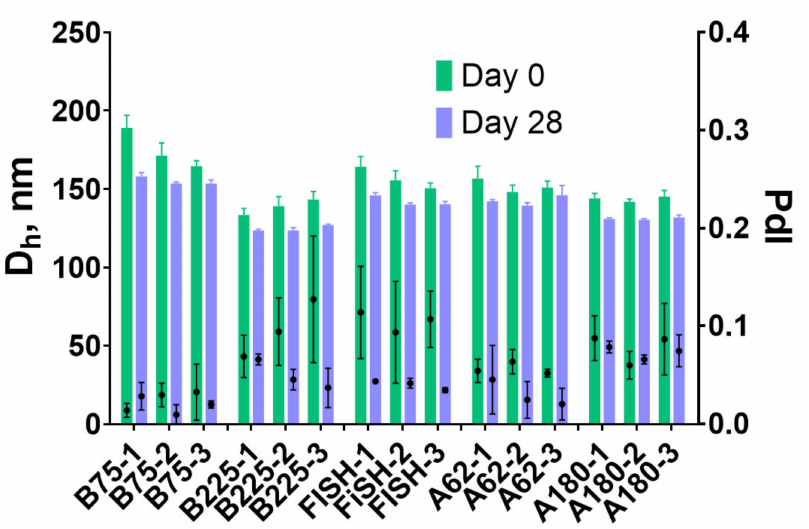
Figure 7. Size (Dh) and polydispersity index (PdI) of gelatin nanoparticles after the synthesis and in 28 days. Mean values of three technical replicates are shown, mean ±